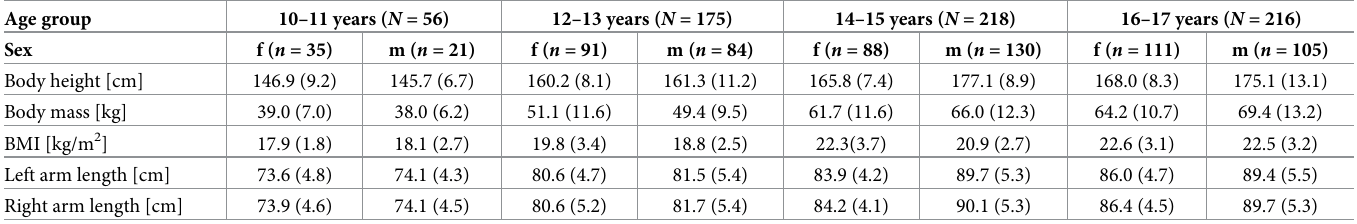
Table 1. Characteristics of the study participants ( N = 665) by age group and